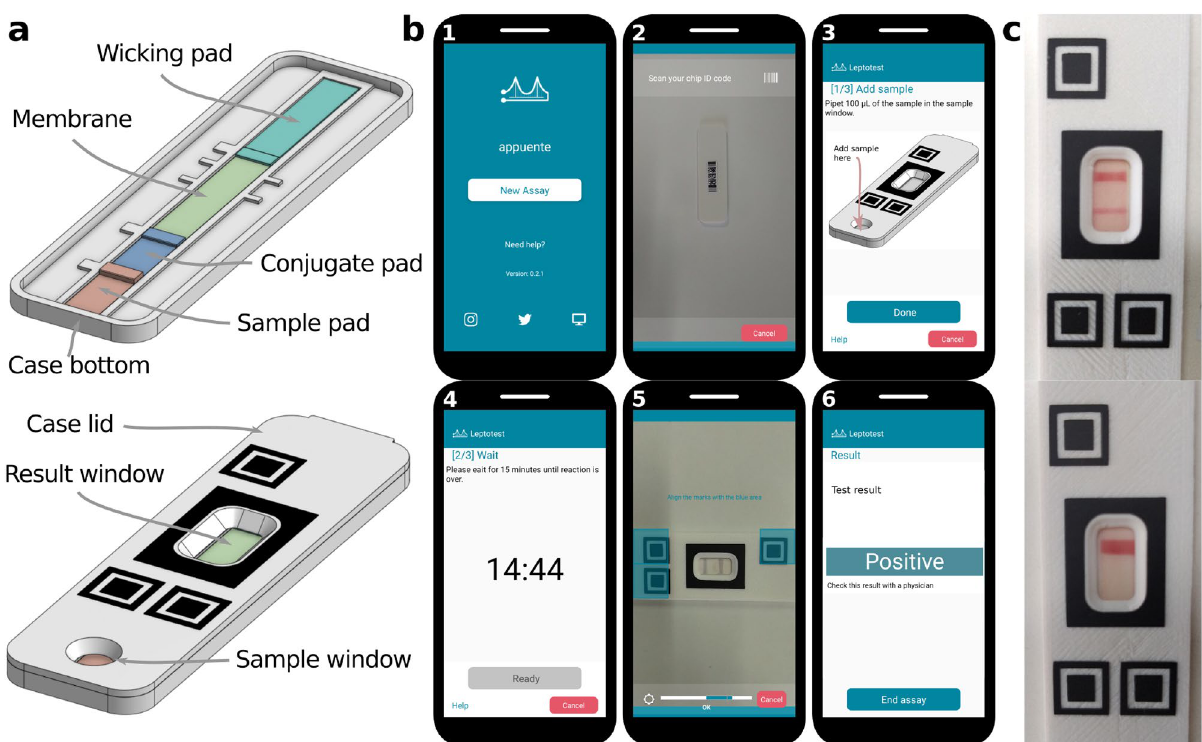
Figure 5. Application case #3. ( a ) A 3D render of the LFIA parts (top panel) and its cassette (bottom panel). ( b ) Screenshots of the custom mobile app created using appuente , at six running steps: (1) Start new test, (2) scan ID code, (3) add sample, (4) chronometer, (5) automatic imaging and (6) result report. ( c ) Real examples of LFIA chips for positive (top) and negative (bottom)